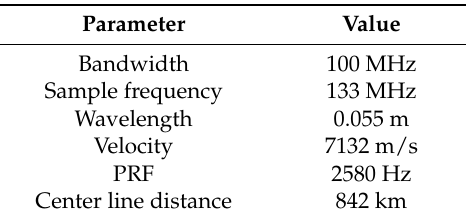
Table 2. Parameters of the GF3-SAR in stripmap mode.